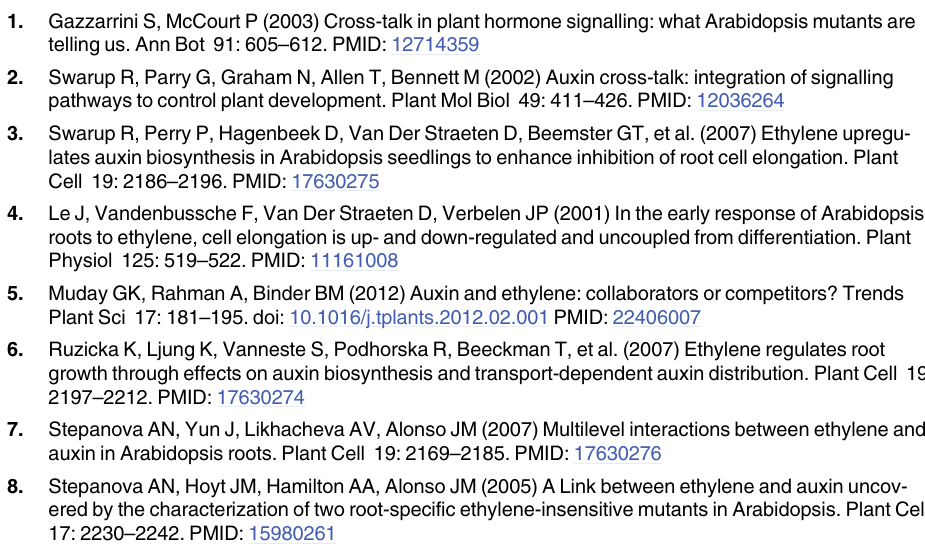
S8 Fig. Primary root elongation of asa1-1 mutant in response to ACC. (a) The primary root phenotypes of Col-0, asa1-1 , ERF1ox and ERF1ox asa1-1 seedlings grown on MS medium with either 0 or 1 μ M ACC for 5 d. Scale bar, 1 cm. (b-c) Primary root length of Col-0, asa1-1 , ERF1ox and ERF1ox asa1-1 seedlings grown on MS medium with either 0 or 1 μ M ACC were measured at the fifth days. Data shown are average and SD (Values are mean ± SD, n = 20). S1 Table. Primers used in this study (5'- to